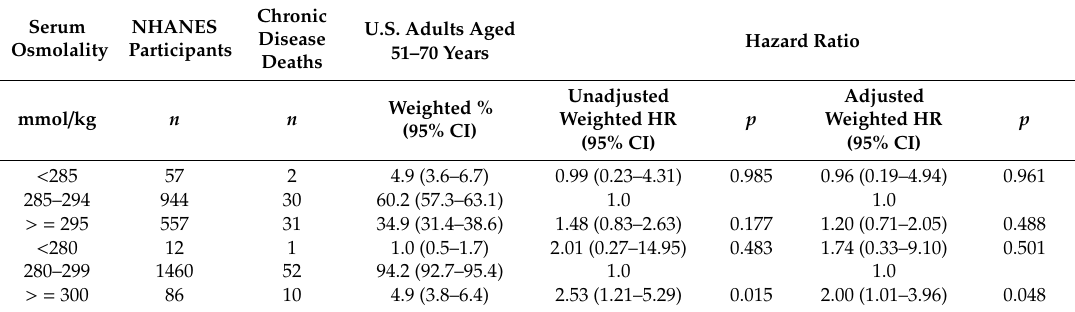
Table A2. Sensitivity analysis checking what range in the serum osmolality distribution contributed to the U-shaped relationship with chronic disease mortality for NHANES 2009–2012 participants aged 51–80